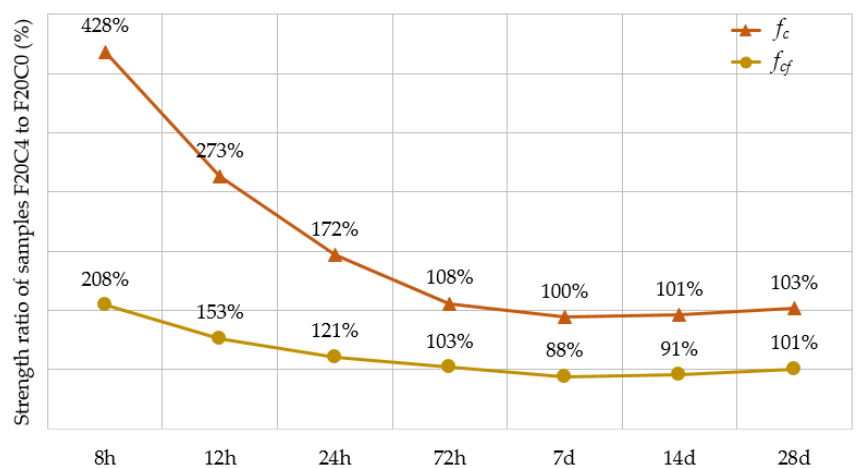
Figure 6. Increase in the compressive strength ( f c ) and tensile strength ( f cf ) of the NA modified paste compared to the reference one.